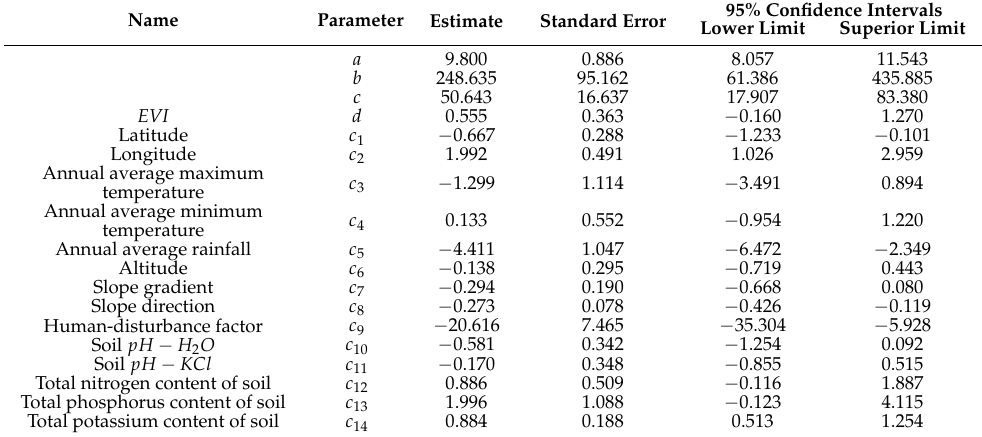
Table 3. Fitting results of tropical rainforest biomass estimation remote sensing model (Model